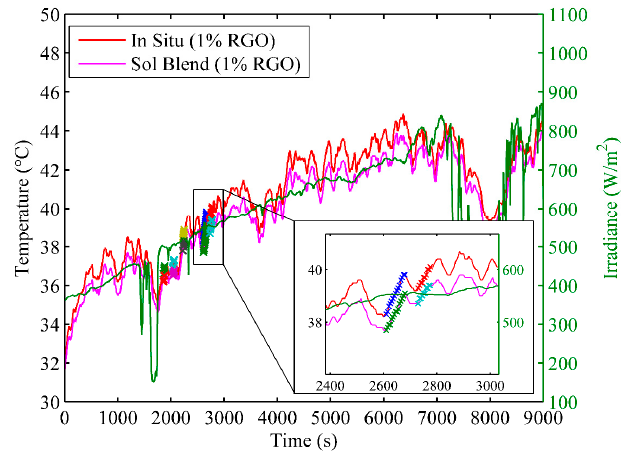
Figure 17. Sets of results that fulfill the required conditions.